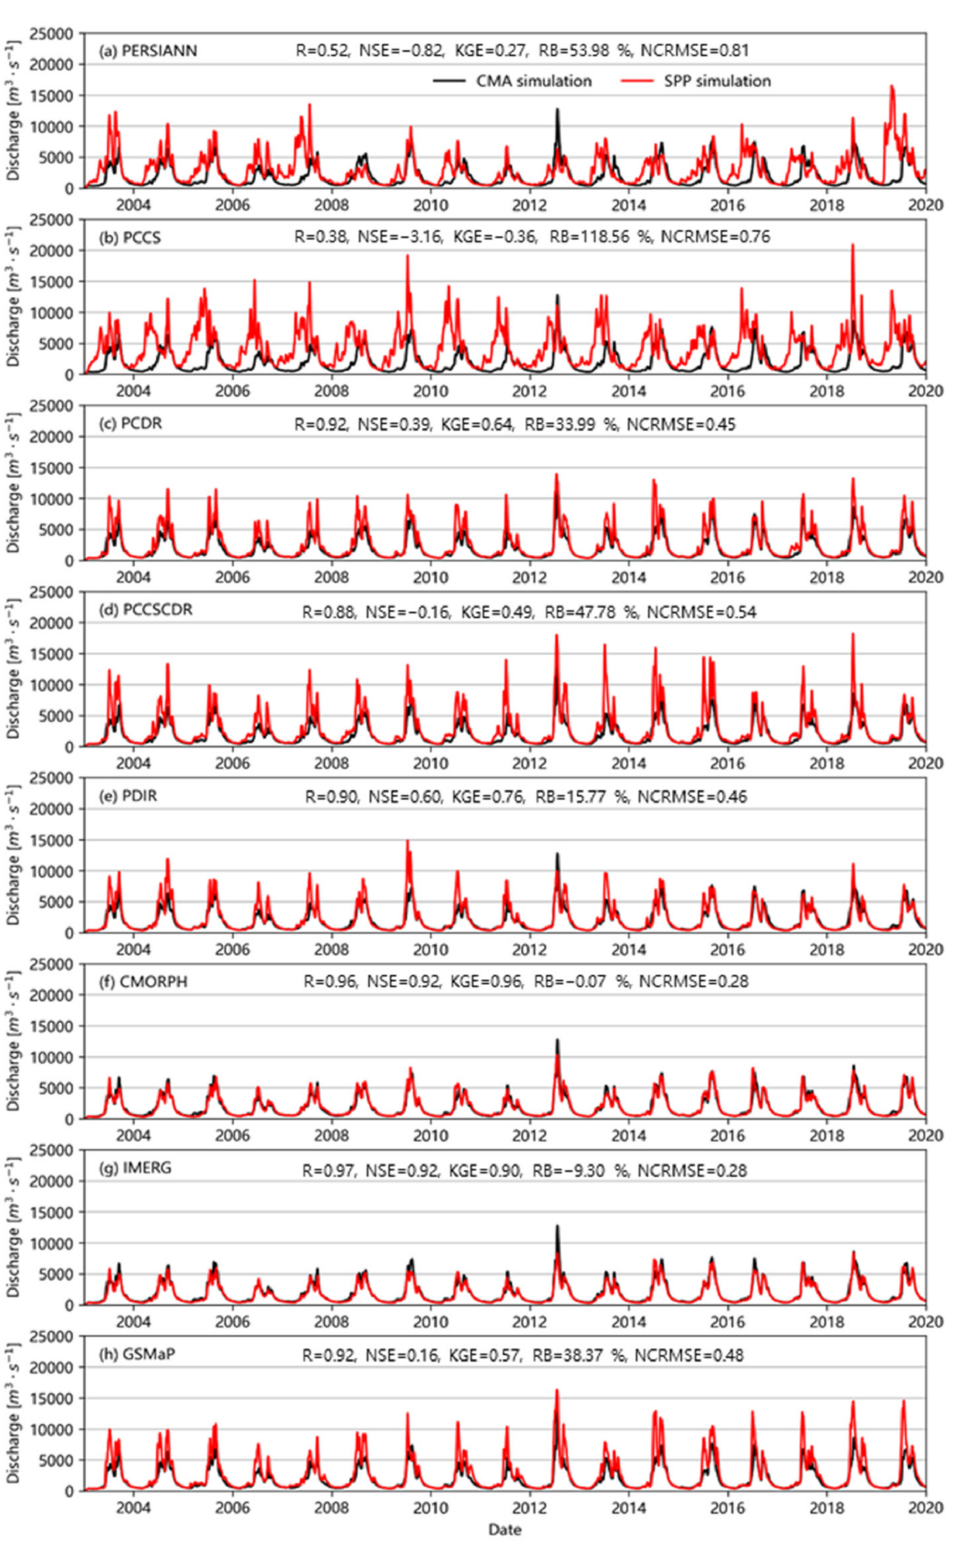
Figure 4. The model simulation forced by CMA observation and eight different SPEs ( a – h ) at the TZL station. Pearson correlation coefficient (R); Nash–Sutcliffe efficiency (NSE); Kling–Gupta efficiency (KGE); Relative bias (RB); Normalized centered root mean square error